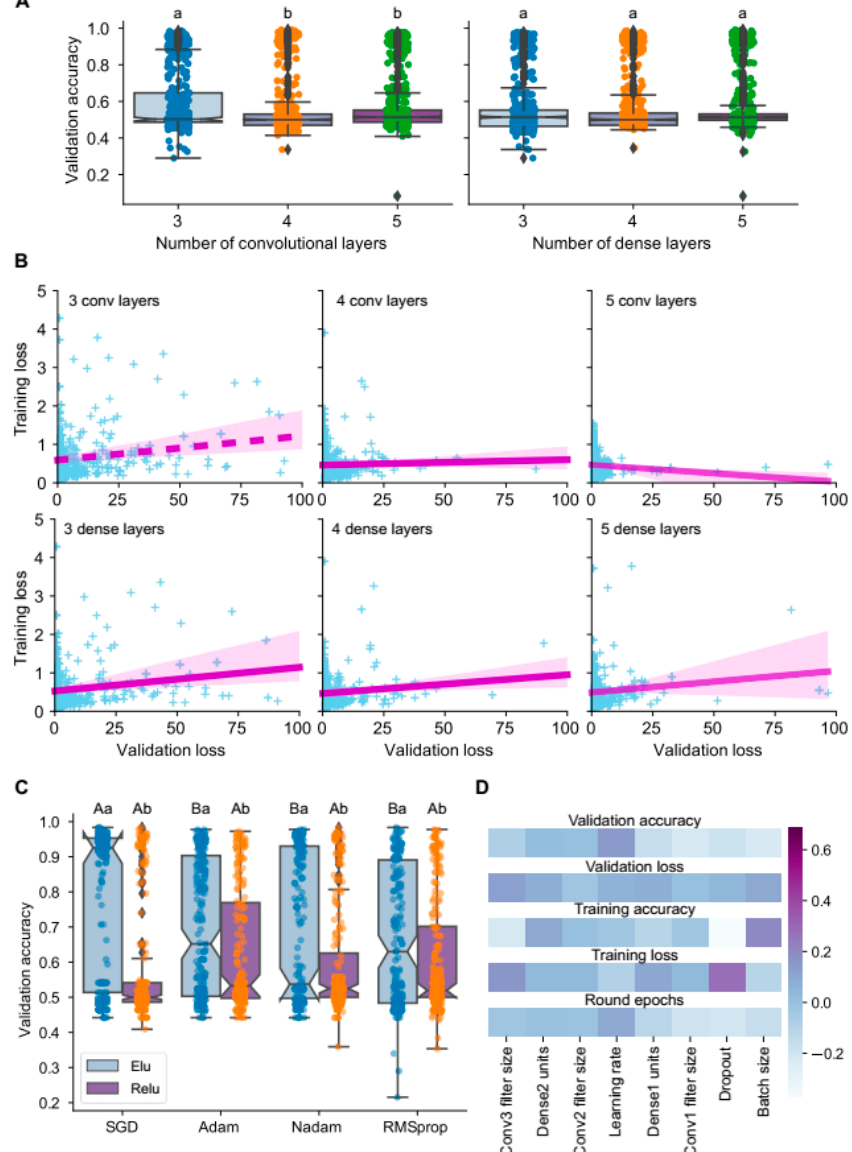
Figure 2. Hyperparameters evaluated in the custom convolutional neural network (convnet) archi- tecture to detect Fusarium head blight disease in wheat seeds. ( A ) Accuracy validation for the number of convolutional and dense layers; boxes followed by different letters are significantly different (Tukey’s test, p < 0.05). ( B ) Training loss and validation loss for the number of convolutional and dense layers. Dashed line indicates a significant difference between the number of layers and the solid line indicates no significant difference (Tukey’s test, p < 0.05). ( C ) Validation accuracy in re- sponse to the interaction between the optimizer and activation function. Different uppercase letters indicate differences between optimizers within each level of the activation function, and different lowercase letters indicate differences between activation functions within each level of the optimizer (Tukey’s test, p < 0.05). ( D ) Correlations among some hyperparameters employed during the custom network architecture optimization. The median, dispersion range (lower and upper quartiles), and confidence intervals (represented as notches) are displayed in all boxplots.